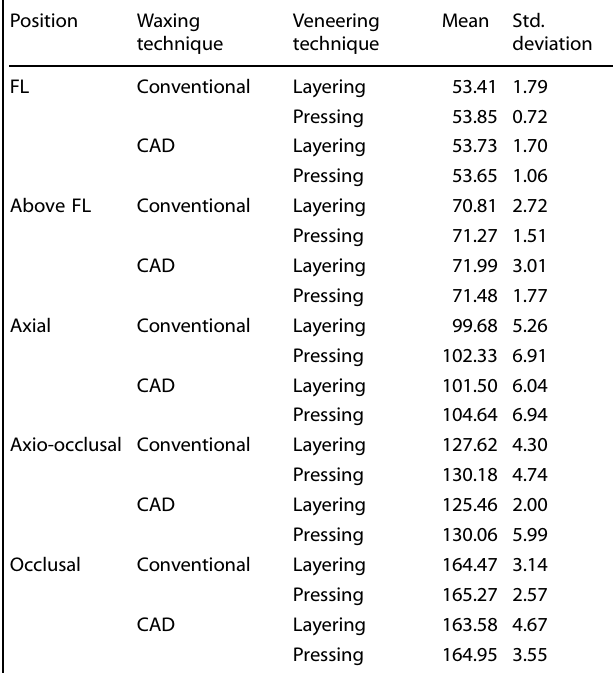
Table 1. Descriptive statistics for internal gap width